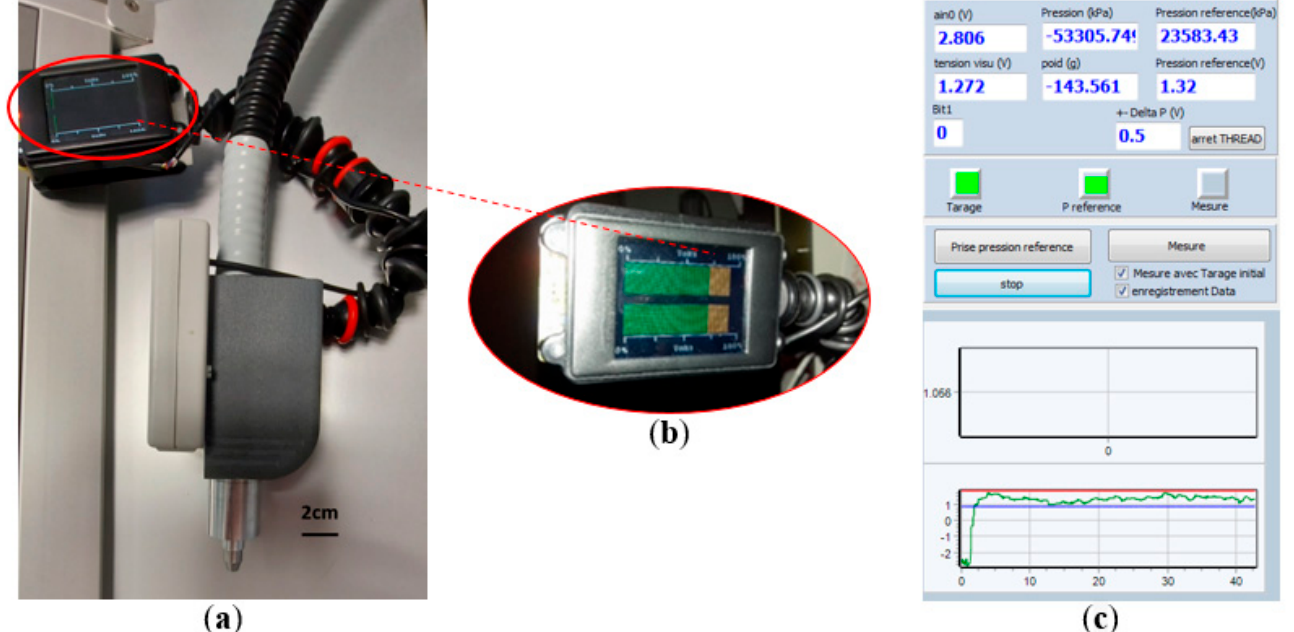
Figure 4. Probe pressure control module. ( a ) General view of the module fixed onto the optical probe of the SpectroLive device. ( b ) Screen fixed onto the optical probe so the user may see it while measuring, displaying the pressure level within (green graph) or outside (orange graph) pre ‐ defined boundaries. ( c ) Human–machine Interface monitoring the probe pressure during the whole spectra acquisition duration: the red and blue lines respectively show the maximum and minimum pressure level previously defined by the user.